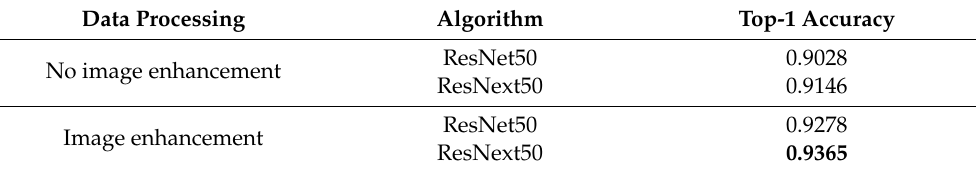
Table 1. Ablation results of image enhancement results (bold means the best